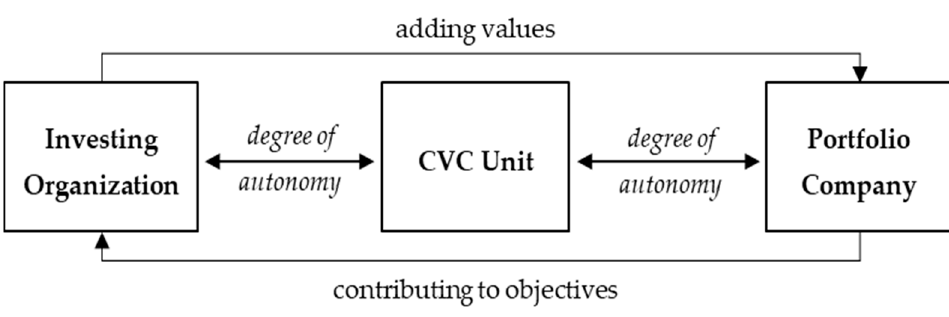
Figure 1. Corporate Venture Capital (CVC) Structure.